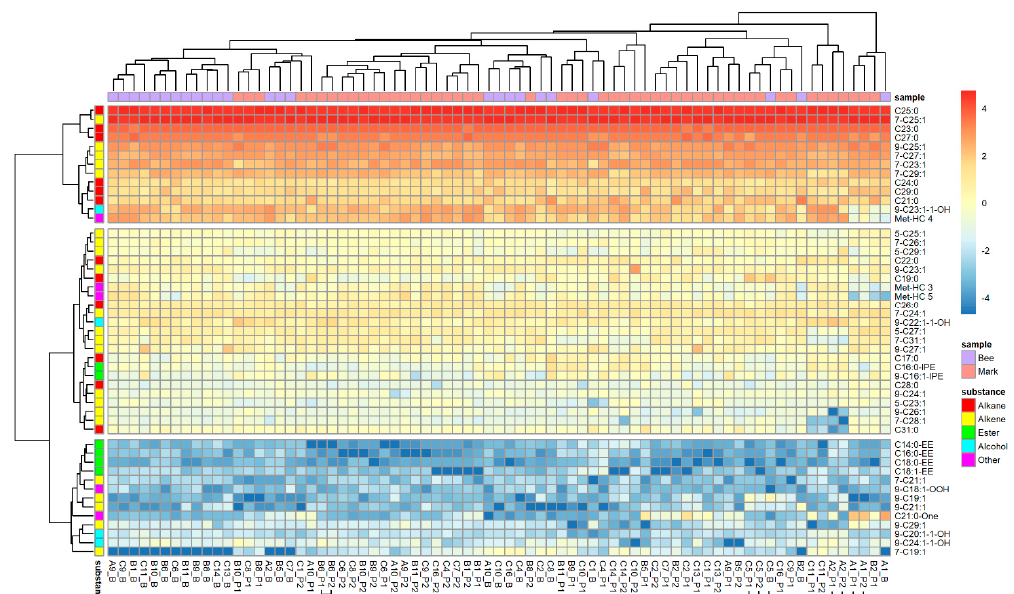
Figure A1. Composition of bee odors and individual scent marks of O. cornuta nests (49 substances). Odor composition of bees was estimated from head and Dufour’s gland extracts (see text). Compounds are arranged in rows, and odor samples are in columns of the heat map. Samples are specified by the ID of the nest and origin of the sample (bouquet of resident bee/number of the filter paper sleeve). Samples of one nest that cluster together are marked by horizontal squared brackets. Origin of samples and substance classes are color-coded for a quick overview.